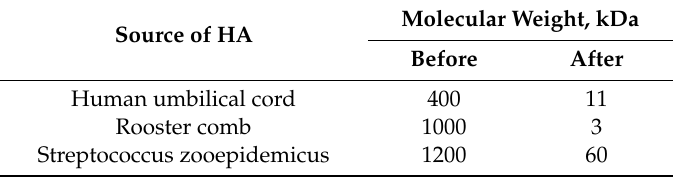
Figure 20. Chromatograms of HA exposed to ultrasound for 0 (HA), 15 (SON-1), 45 (SON-2), 60 (SON-3) minutes. Reproduced from [110], with permission from Portland Press, Ltd., 2020. Table 6. Degradation of HA derived from various sources by sonication. Reproduced from [112], with permission from Springer Nature,